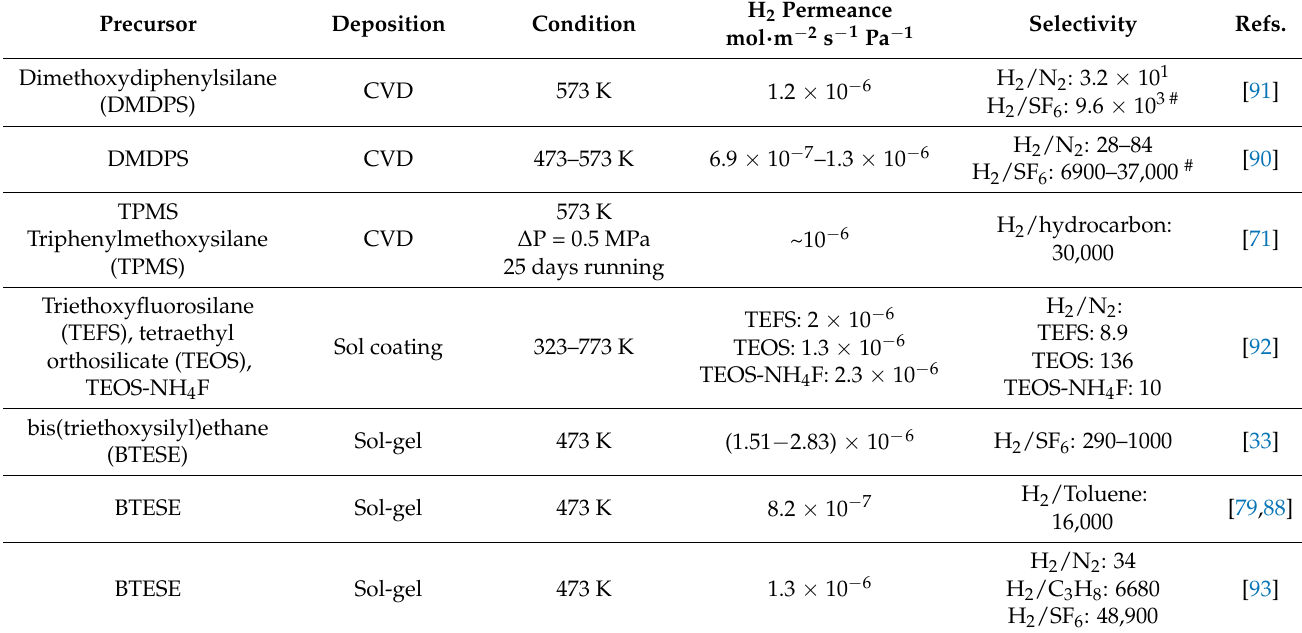
Table 3 summarises fabrication methods and properties of silica-based membranes used for the separation of hydrogen in MCH-TOL systems reported in recent literatures. Table 3. Silica based membranes * for hydrogen separation reported in recent